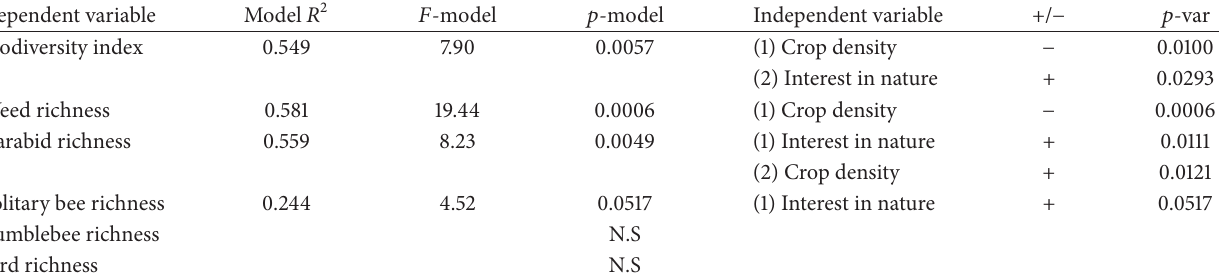
variables. 𝑃 -values are presented both for the full models ( 𝑝 -model) and single independent variables ( 𝑝 var). 𝑅 2 values and 𝐹 -values are presented for the full models. The direction of the effect is indicated by the +/ − column.